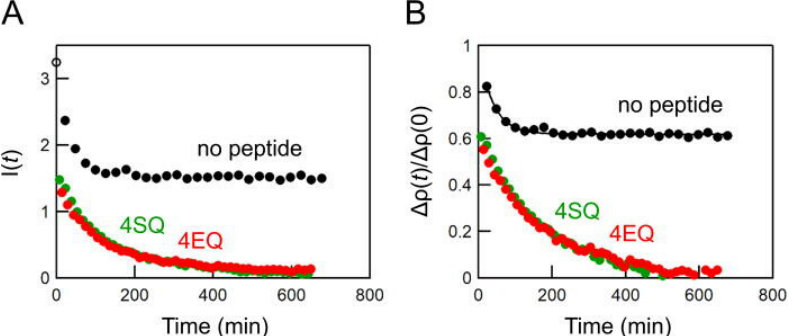
Figure 10. Peptide-enhanced exchange of lipids in vesicles [255]. ( A ) The integrated intensity as a function of time showing that two peptides engineered to scramble the lipids in the bilayer (4SQ and 4EQ) cause greater lipid exchange than when no peptide is present. ( B ) The decay in scattering contrast with time for the same system. The image is Figure 3 of reference [255] by Nakao et al.,